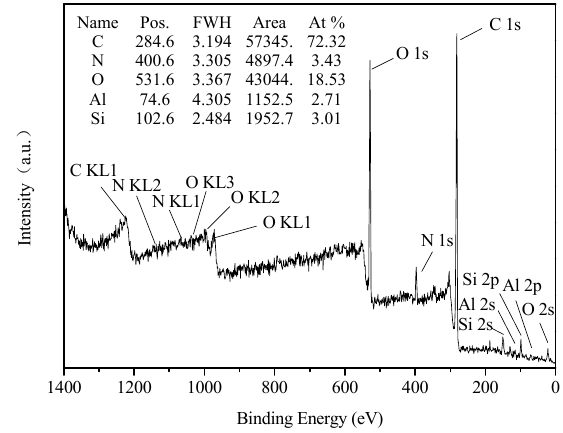
Figure 1. High-resolution XPS spectra of dry sewage sludge.